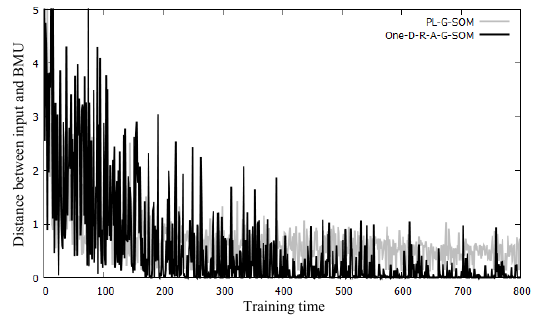
Fig. 8. Comparison of learning convergence: Gray lines for conventional PL-G-M; Black lines for One-D-R-A-G-SOM.